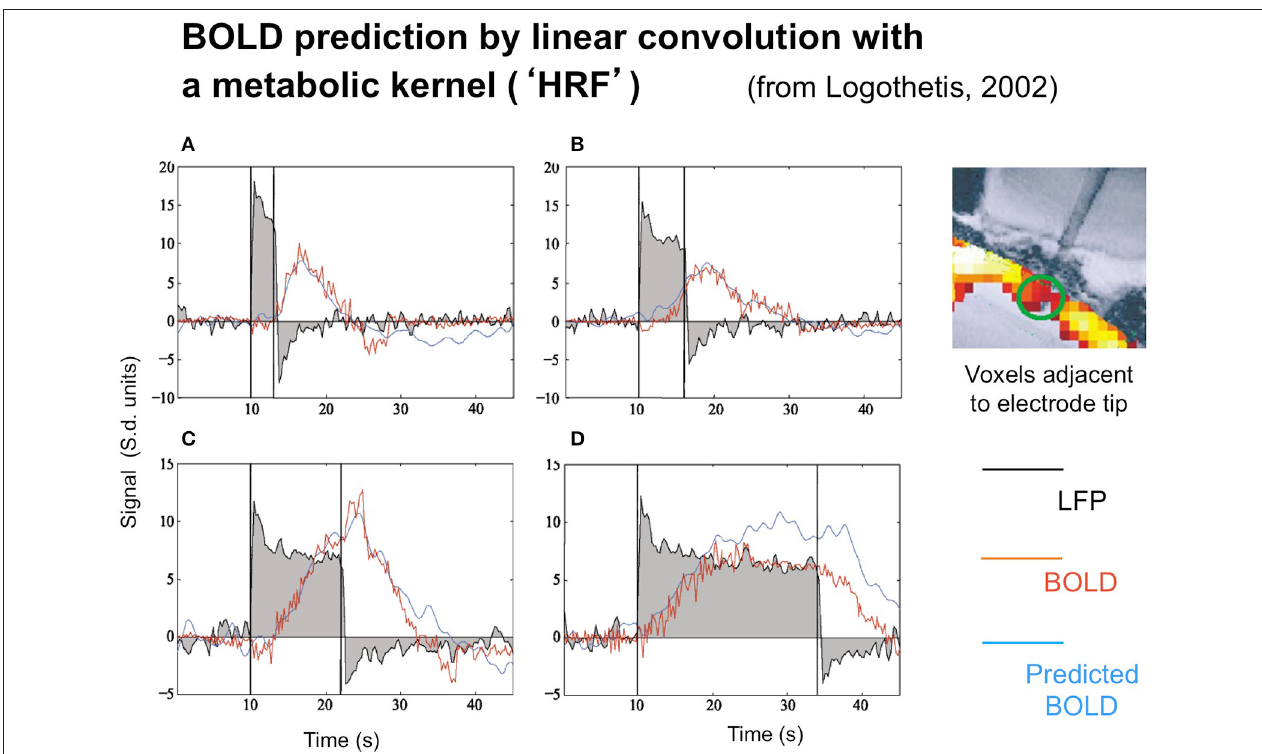
FIGURE 2 | Time course of the local field potentials (black trace), BOLD (red blue trace), and predicted BOLD (red trace) to a continuous dynamic stimuli (black rectangle) of 3, 6, 12, and 24s duration (A–D, respectively from Logothetis, 2003, with permission). The prediction was generate by linear convolution of the recorded LFP signal with a hemodynamic response function (see Logothetis, 2002, for details).